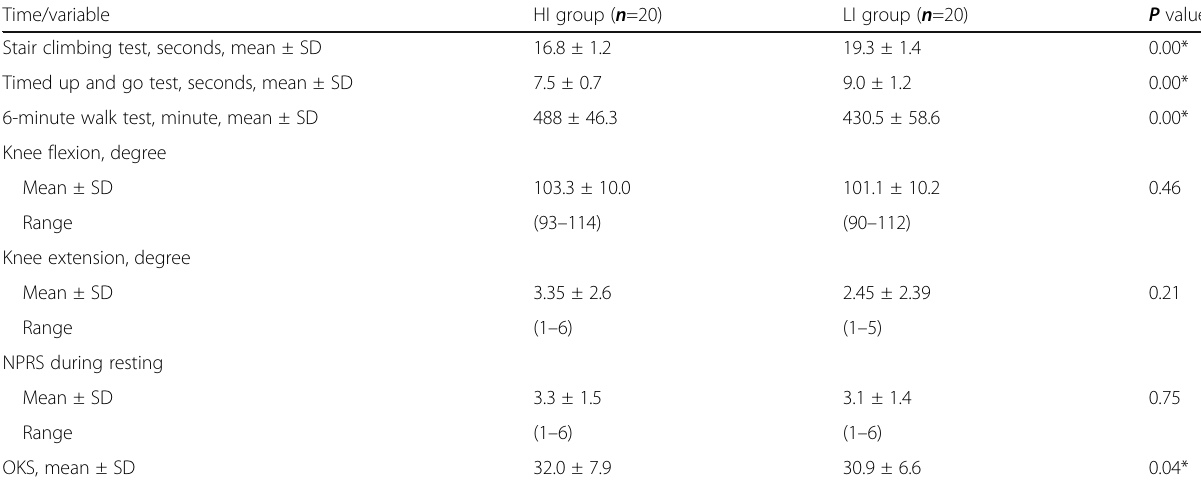
Table 3 Post-operative outcome measures of both groups at 3 months